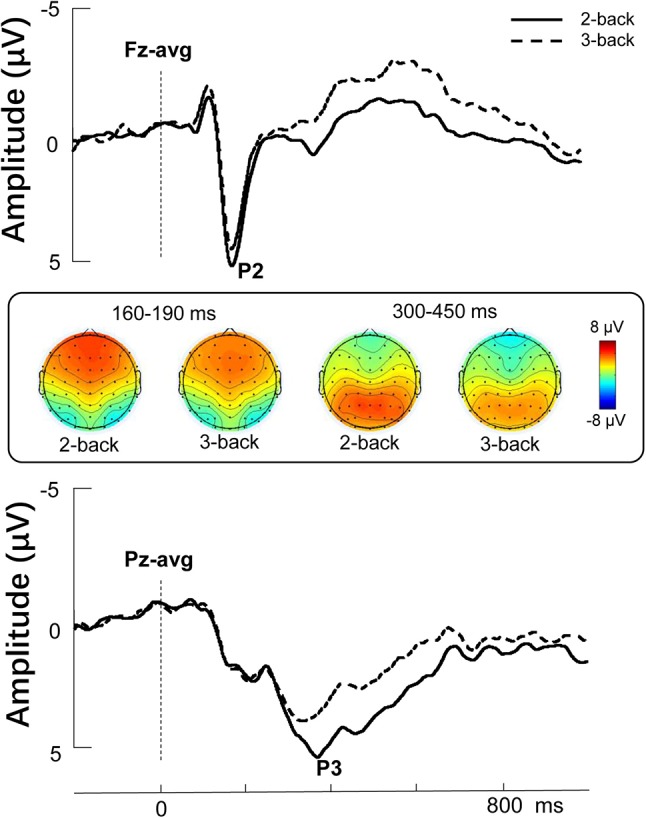
Stimulus-locked grand average ERP amplitude (μV) elicited during the 2-back and 3-back conditions. Topographies represent the scalp distributions of the P2 (160–190 ms) and P3 components (300–450 ms).